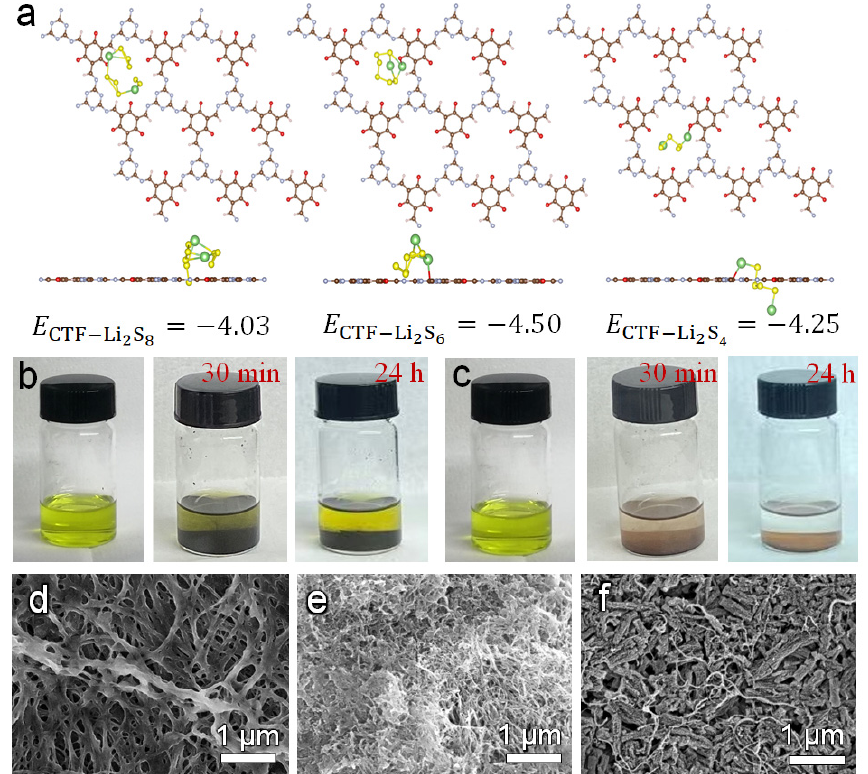
Figure 5. ( a ) DFT calculations of Li 2 S 8 , Li 2 S 6 , and Li 2 S 4 adsorption on CTF, static-adsorption experiments of ( b ) CNT and ( c ) CTF in a Li 2 S 4 solution. SEM images of ( d ) the Celgard separator, ( e ) CNT/Celgard separator, and ( f ) CTF/CNT/Celgard separator after cycling.